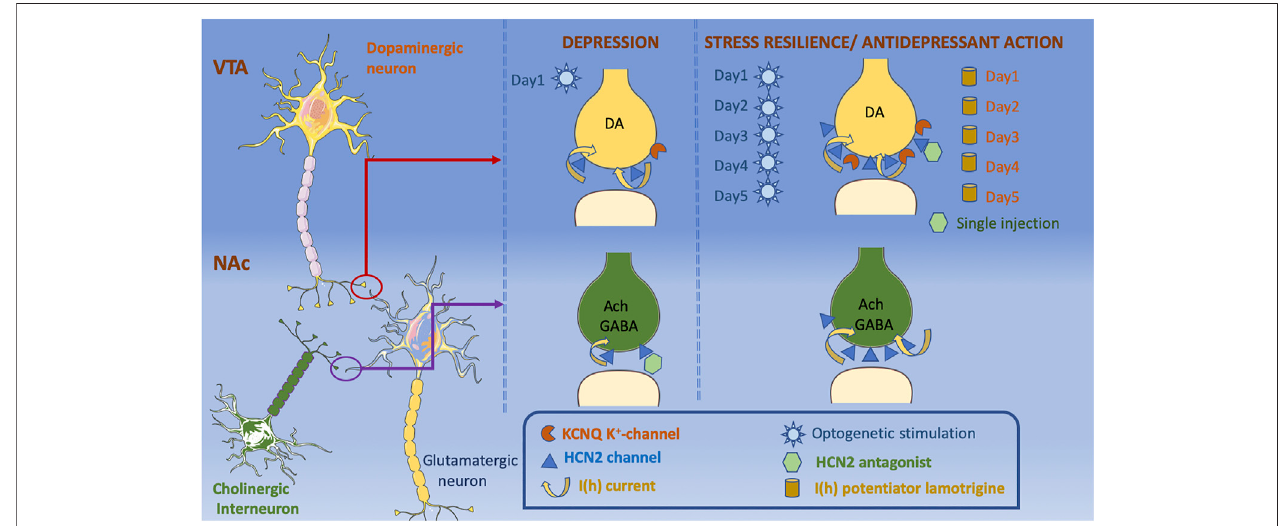
FIGURE 4 | The decrease in the expression of HCN2 channels in NAc on both dopaminergic terminals projecting from VTA and local ChIN terminals is depressogenic. Decrease in I(h) currents in ChIN terminals is associated with depression-like phenotype, whereas an increase in I(h) currents on the VTA dopaminergic terminals is observed in both stress susceptible and stress resilient mice. K + channels are increased only in the stress resilient mice counterbalancing the effects of increased I(h) currents. Application of an HCN2 antagonist into NAc causes a depressogenic phenotype, whereas it has antidepressant effects when applied into VTA.Lamotrigineadministration for5-daysalso reducedepressogenic behaviors.Acute optogeneticstimulation ofVTA dopaminergicneuronsincreasedepression-like behaviors, whereas chronic optogenetic stimulation of VTA dopaminergic neurons shows antidepressant effects. Cellular templates are copied from Servier Medical Art